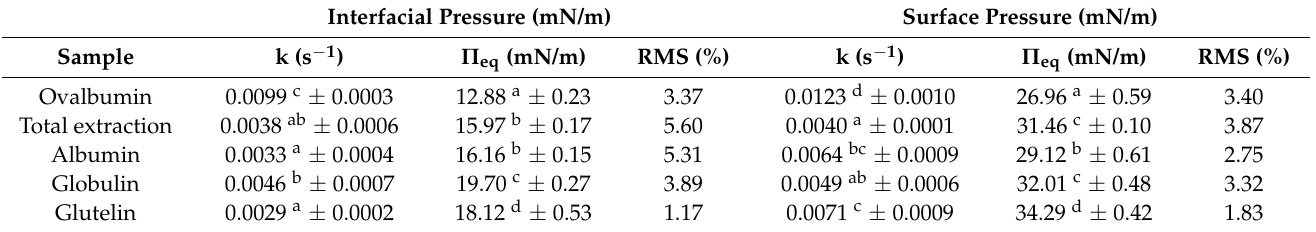
Table 4. Comparison of the effect of surface and interfacial pressure of chickpea proteins concerning